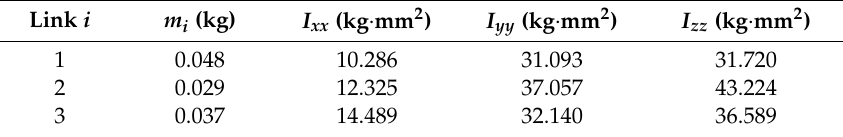
Table 2. Dynamic parameters of the single finger of the